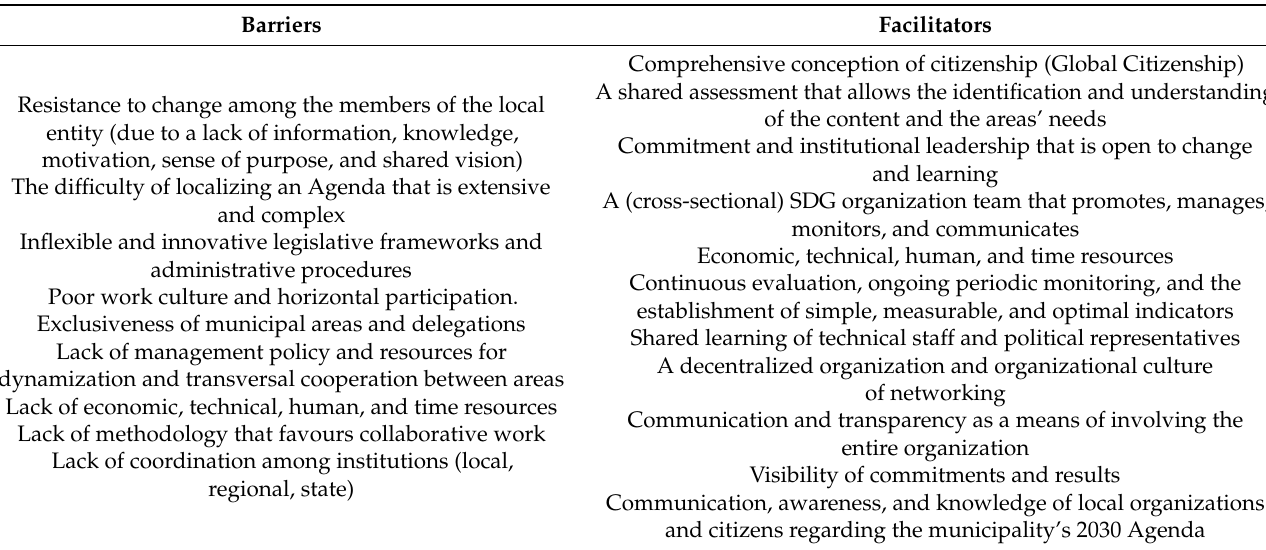
Table 3. Barriers and facilitating